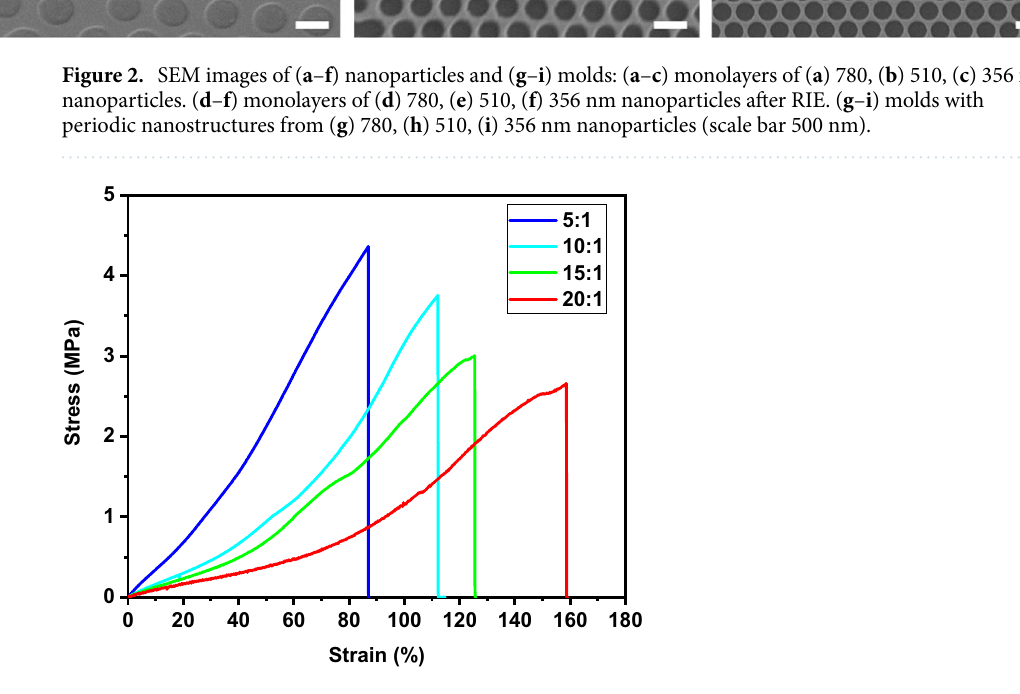
Figure 3. Results of tensile test with PDMS substrates for different mixing ratios (base : curing